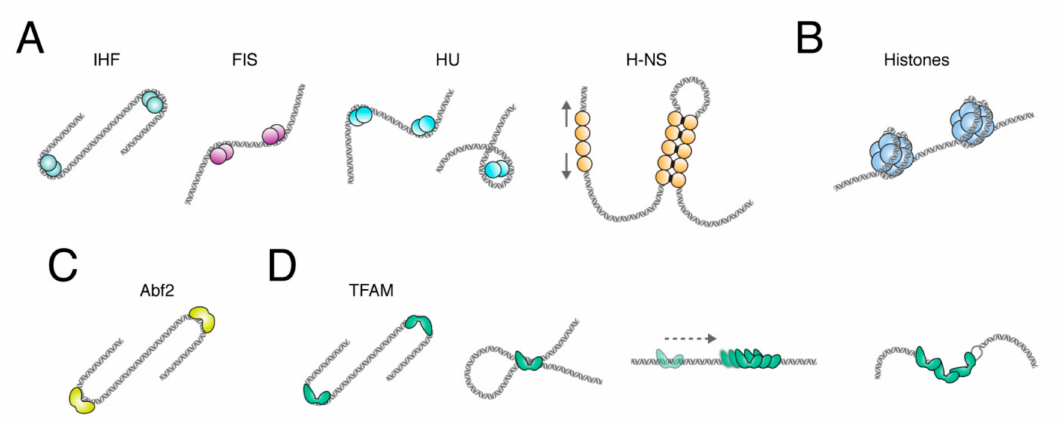
Figure 1. Architectural protein activities from bacterial nucleoids, eukaryotic chromatin, and mitochondrial nucleoids. ( A ) The bacterial chromosome is organized by several di ff erent NAPs that bend (IHF, FIS, HU), wrap (HU), and sti ff en (arrows) and bridge (H-NS) DNA (grey duplex). ( B ) In the eukaryotic nucleus, chromosomal DNA is tightly wrapped around a nucleosome comprised of a histone octamer. ( C ) In yeast mitochondria, mtDNA is compacted by Abf2, which induces sharp U-turns. ( D ) In mammalian mitochondria, TFAM compacts mtDNA via U-turns and bridging (two left panels). In addition, TFAM slides along DNA (dashed arrow) and binds cooperatively to a TFAM patch, as well as increases DNA flexibility via local denaturation (DNA bubble, right